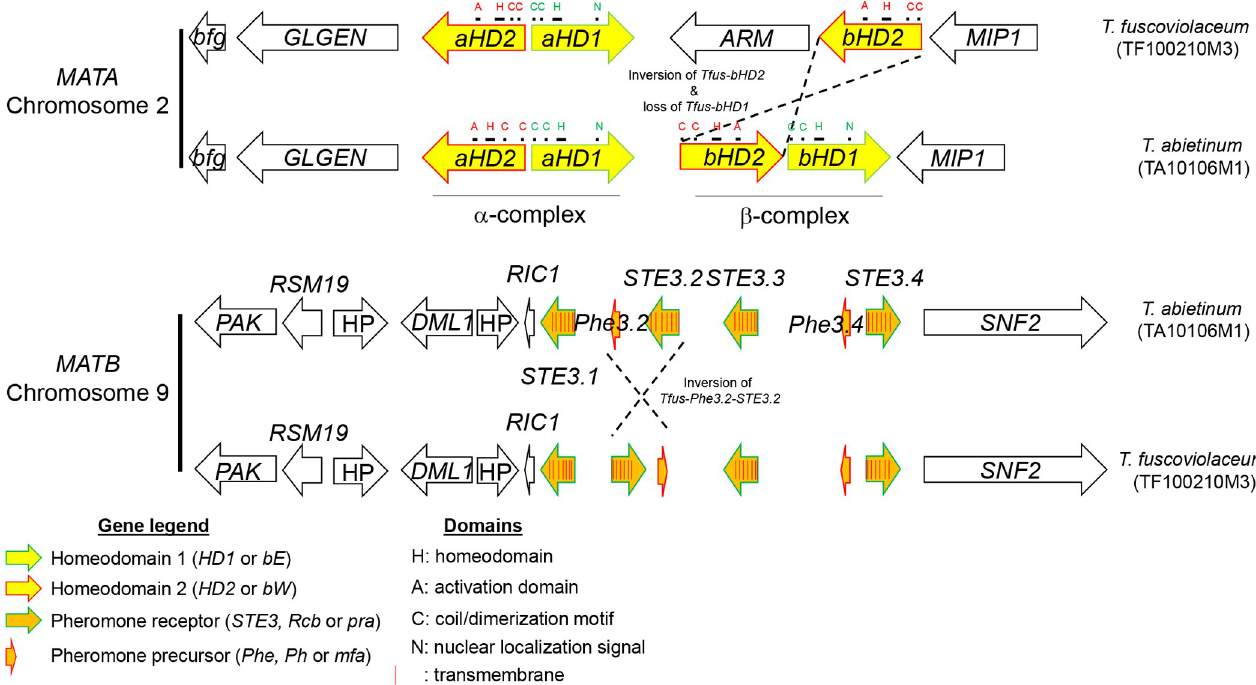
Fig 2. Two homeodomain complexes in MATA and four putative pheromone receptors in MATB were detected in T . abietinum and T . fuscoviolaceum . Schematic representation of the gene composition and direction in both reference genomes. Homeodomain, other functional domains, pheromone precursors and pheromone receptors genes are represented as indicated in the legend. The rest of the genes were colored in black, and the gene names were indicated inside the arrows. aHD : alpha-complex homeodomain ; ARM : ARM-repeated containing protein; bfg beta-flanking gene; bHD : beta-complex homeodomain; DML1 : mtDNA inheritance protein; GLGEN : glycogenin-1; HP: hypothetical protein; MIP1 : mtDNA intermediate peptidase; PAK : serine/threonine protein kinase; RSM19 : 37S ribosomal protein S19 ; RIC1 : RIC1-domain containing protein ; SNF2 : Snf2 family dna-dependent ATPase; STE3 : GPCR fungal pheromone mating factor. The Fig is not drawn to scale to facilitate